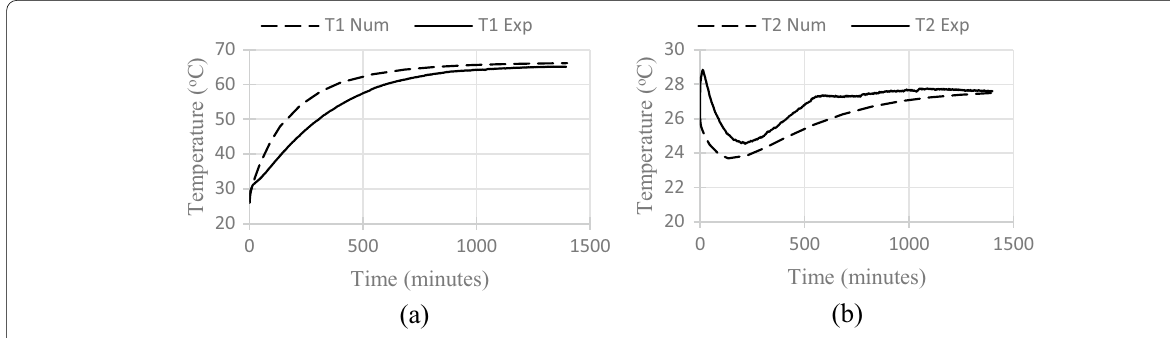
Fig. 10 Experimental and numerical temperature profiles for panel P2, a cold and b hot surfaces.